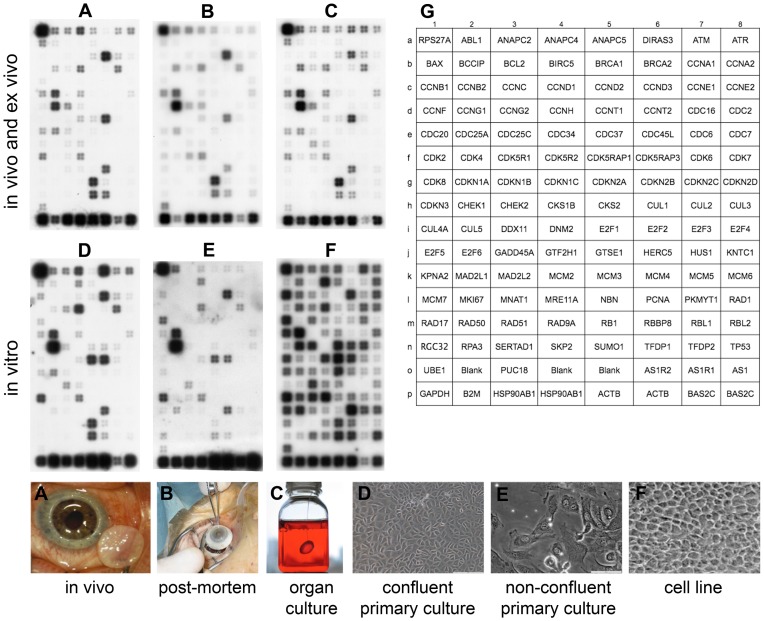
Microarray analysis of mRNA extracted from endothelial cells collected on six biological models.(A) in vivo corneas (reference group); (B) post-mortem corneas; (C) organ-cultured corneas; (D) confluent primary culture; (E) non-confluent primary culture; and (F) in vitro confluent cell line. Genes expressed were identified as a specific hybridization signal that appeared as tetra-spots. In addition to the 112 genes of interest, each chip contained five housekeeping genes for normalization (GADPH, beta-2-microglobuline (B2M), 2× HSP90AB1, 2× Actin beta (ACTB)), seven negative controls: PUC18 plasmid DNA, Artificial Sequence 1 related 2 (AS1R2), Artificial Sequence 1 Related 1 (AS1R1), Artificial Sequence 1 (AS1) and three blank spots, and two positive detection controls: two biotinylated Artificial Sequence 2 Complementary sequence (BAS2C) at increasing gradient. A key to gene coordinates is shown in panel G.